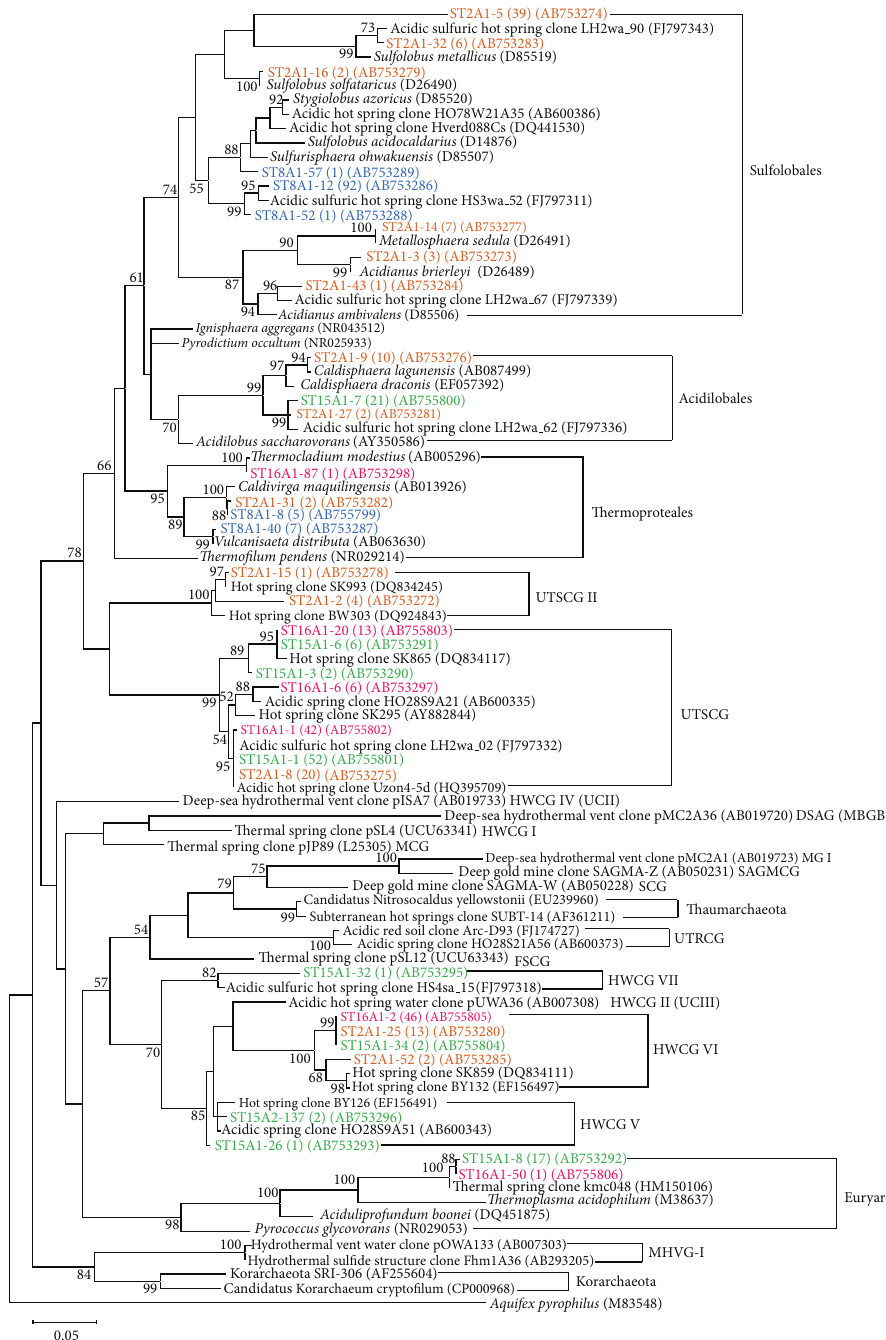
Figure 2: Phylogenetic tree of archaeal 16S rRNA gene sequences detected in Kirishima hot springs. Bootstrap values ( > 50%) based on 1000 replicates are indicated at nodes. The scale bar indicates the number of nucleotide substitutions per position. Number in the parenthesis with phylotypenamerepresentsthenumberofclonesofeachphylotype.TheDNAdatabaseaccessionnumbersarealsoindicatedintheparenthesis. Aquifex pyrophilus is used as an outgroup species. The phylotype names derived from Pond-A, Pond-B, Pond-C, and Pond-D shown in blue, yellow, red, and green, respectively. UTSCG: uncultured thermoacidic spring clone group [16], HWCG I: hot water crenarchaeotic group I [6, 46], HWCG II (known as UCIII): uncultured crenarchaeal group III [15, 45, 46], HWCG IV (also known as UCII) [45, 49, 50], DSAG (known as MBGB): deep-sea archaeal group (marine benthic group B) [49, 51], MCG: miscellaneous crenarchaeal group [5, 50, 52, 53], MG I: marine crenarchaeotic group I [49, 54], SAGMCG: South Africa gold mine group [52], SCG: soil crenarchaeotic group [52], UTRCG: uncultured Thaumarchaeota-related clone group [16], FSCG: forest soil crenarchaeotic group [6, 55], and MHVG-I: marine hydrothermal vent group I [15, 16,